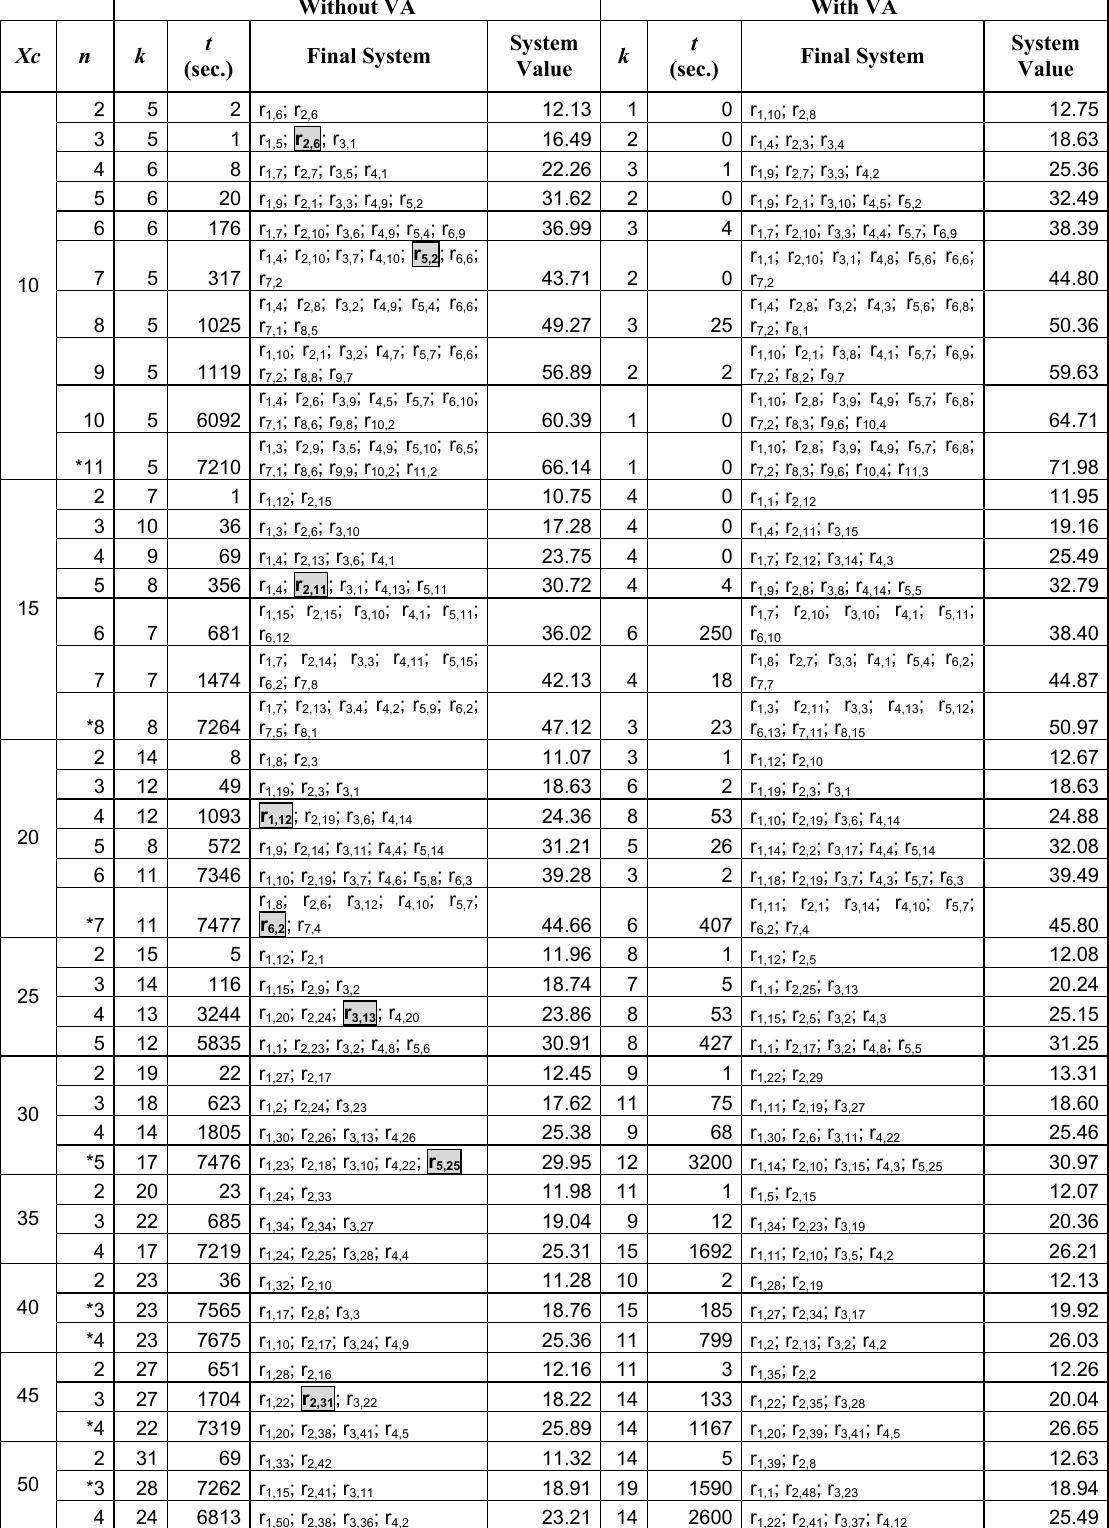
Table 3. Computational